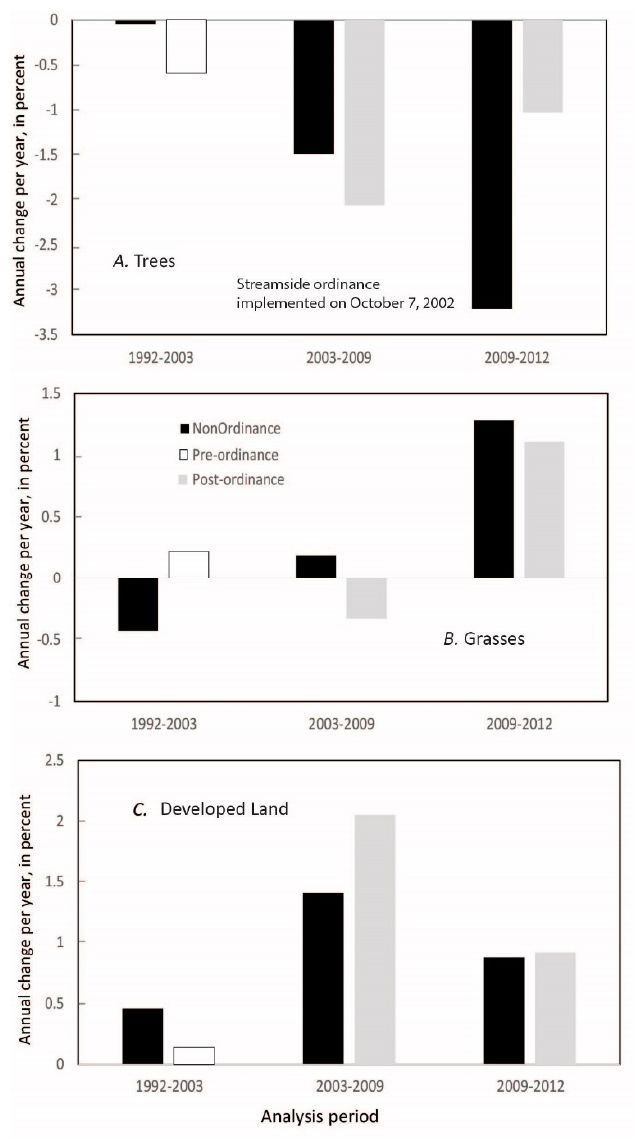
Figure 4. ( A ) Change in Trees within the city of Overland Park, KS, USA, inside and outside